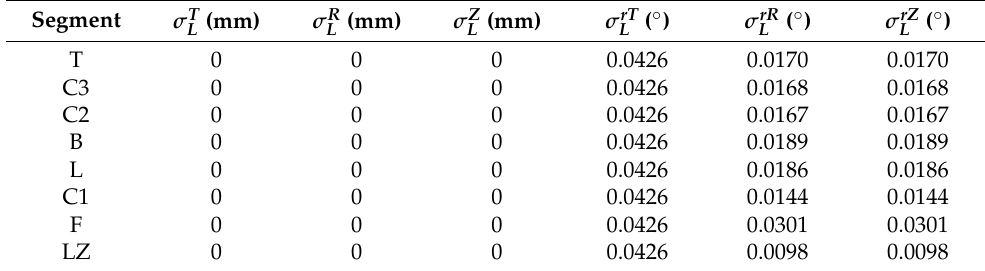
Table 2. Standard deviation of the location